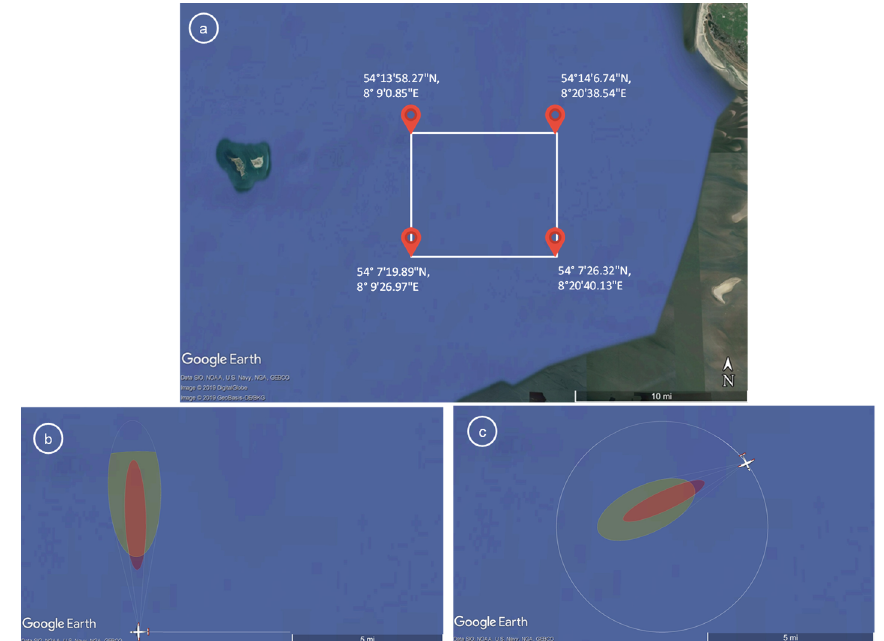
Figure 23. ( a ) Google Earth image showing a part of the test site. The region within the white box marks the area where the data were acquired during ( b ) a linear and ( c ) a circular F-SAR flight track. The red and yellow ellipses in ( b ) and ( c ) are the 3 dB antenna footprints of the X- and L-band antenna, respectively. Table 2. Radar system and acquisition geometry parameters for the linear and circular flight.